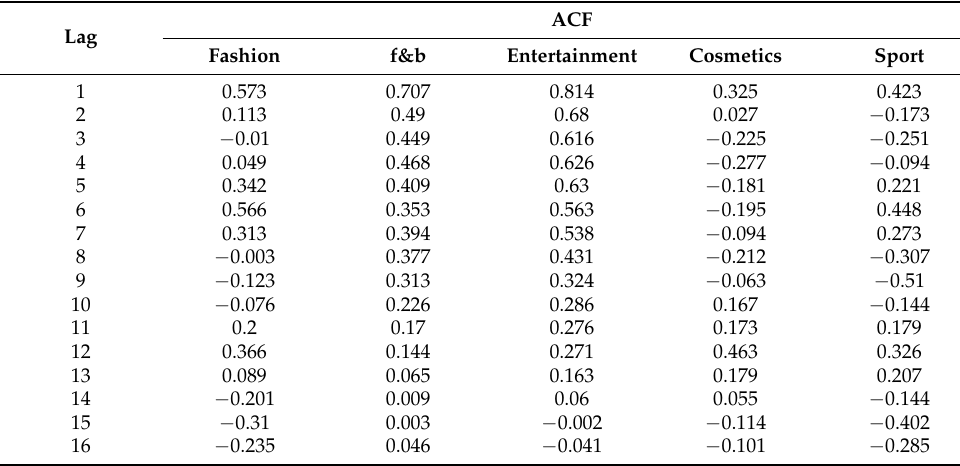
Table 2. ACF of each retail category’s